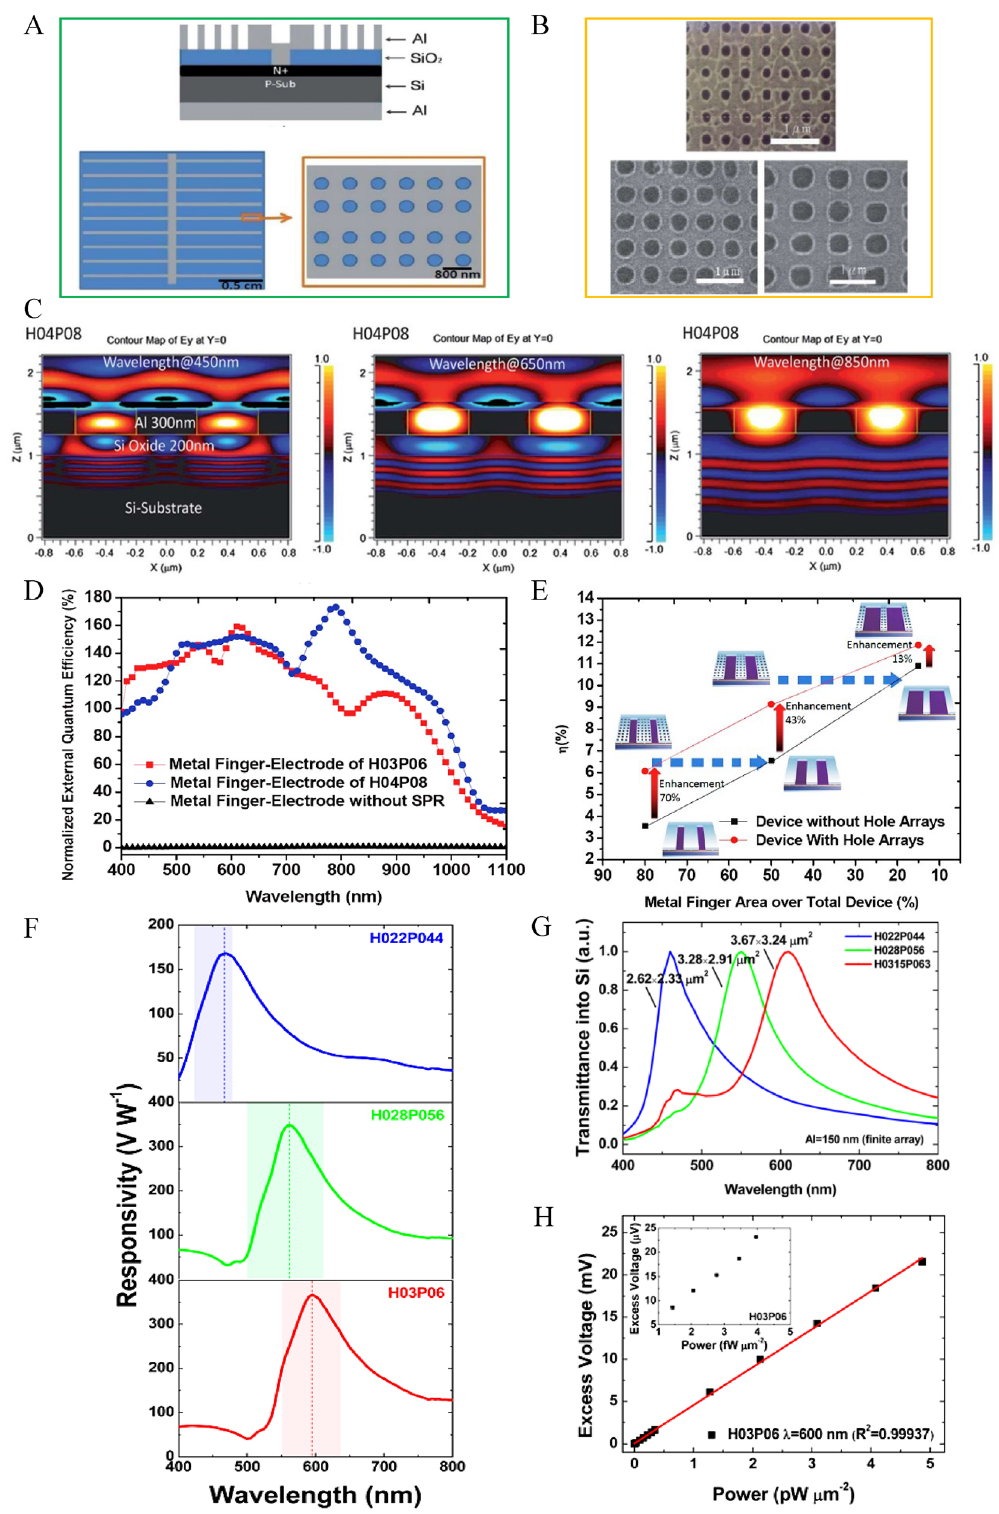
Figure 3: (A) Schematic representation and (B) top-view SEM images of plasmonic silicon-based solar cells featuring hole array structures on the metallic finger electrode. (C) The electric field distributions of the light at the wavelengths of 450, 650, and 850 nm propagating through the H04P08holearray structureon a Si substrate. (D)The externalquantumefficiencies of the devices with andwithouthole array structures. (E)Measured efficienciesof Si-basedsolarcellswithdifferentarrangementsof